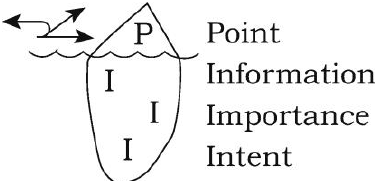
Figure 3a Information Iceberg: Discount of Meaning - Personal